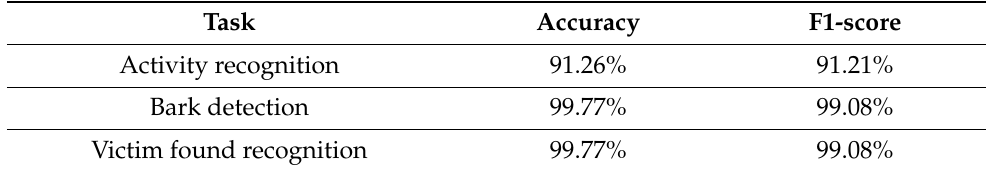
Table 10. Obtained F1-score and accuracy results for tasks of activity recognition, bark detection, and victim found recognition regarding two evaluation SaR scenarios.